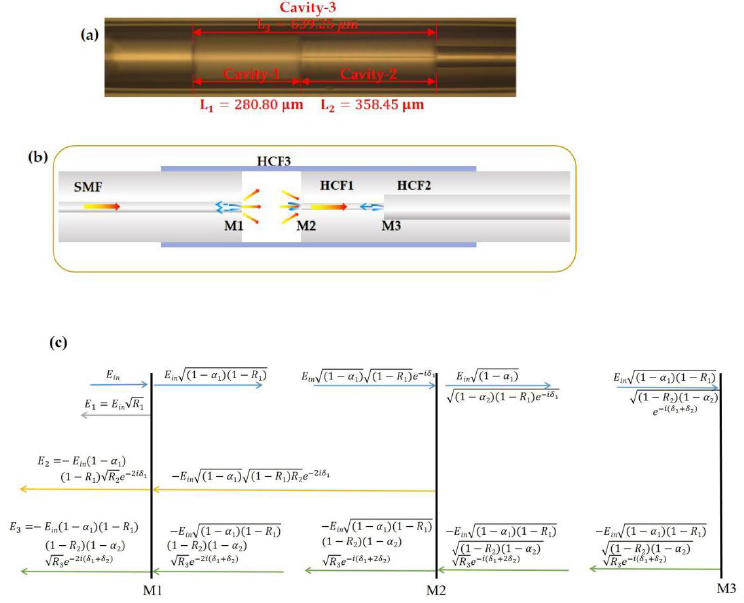
Figure 2. ( a ) The microscope image and ( b ) illustrative diagram of the FPI structure. ( c ) Three-reflector model.